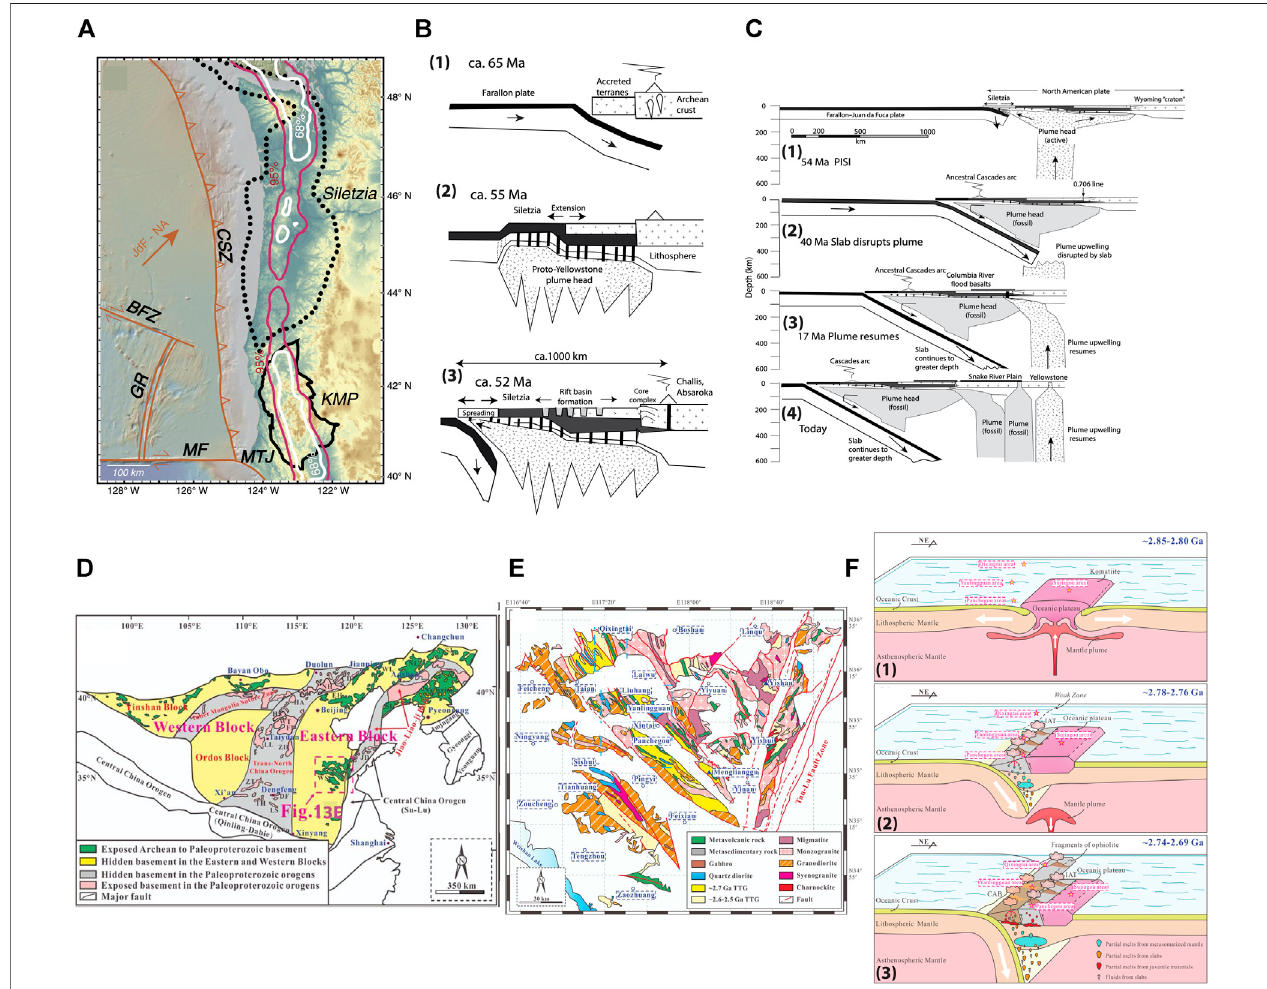
FIGURE 13| (A) Present-day tectonic setting of the Cascadia region. Klamath Mountains province (KMP) and Siletzia are shown by solid and dotted black outlines, respectively. Plate boundaries are illustrated in orange. Abbreviations: CSZ — Cascadia subduction zone, MF — Mendocino fault, GR — Gorda Ridge, BFZ — Blanco fracture zone, MTJ — Mendocino triple junction; JdF — Juan de Fuca; NA — North America (adapted from Piotraschke et al., 2015). (B) Schematic scenarioofCascadiaplume-induced subduction initiation. (1) At ∼ 65 Ma, theFarallon platewas subducting beneath thewestern margin ofNorth America, comprising Archean crust of the Wyoming craton and accreted terranes to the west. (2) Interaction of the ∼ 1,000 km diameter Proto-Yellowstone plume head with overlying lithosphere weakened the Farallon plate, leading to cessation of subduction and widespread extension above the plume head at ∼ 55 Ma. Lithospheric weakening on the western side of the plume head resulted in collapse of the Farallon plate and (3) initiation of the Cascadia subduction zone. (C) Schematic illustration of the evolution of the Cascadia margin and the Siletzia- Yellowstone plume. This panel shows freezing of plume upwelling between ∼ 50 and 20 Ma, due to interplay of the plume and subducting slab. Plume upwelling resumed when the slab and plume separated suf fi ciently due to westward motion of North America. Panels in (B,C) are adapted from Stern and Dumitru, (2019). (D) Geological map of the North China Craton. Thedashed pink rectangle shows the location of (E) . (E) Geological map of the Western Shandong Terrane. TTG stands for tonalitic-trondhjemitic-granodioritic pluton. (F) Schematic tectonic model of Gao et al. (2019) illustrating the tectonic evolution of the Western Shandong Terrane from (1) extension at ∼ 2.85 – 2.8 Ga (during the early stage of plume-lithosphere interaction) to (2) compression at ∼ 2.78 Ga leading to subduction initiation and (3) development of a self-sustaining subduction zone. IAT and CAB stand for island arc tholeiite and calc-alkaline basalt, respectively. Panels in (D,E) are adapted from Gao et al. (2019).